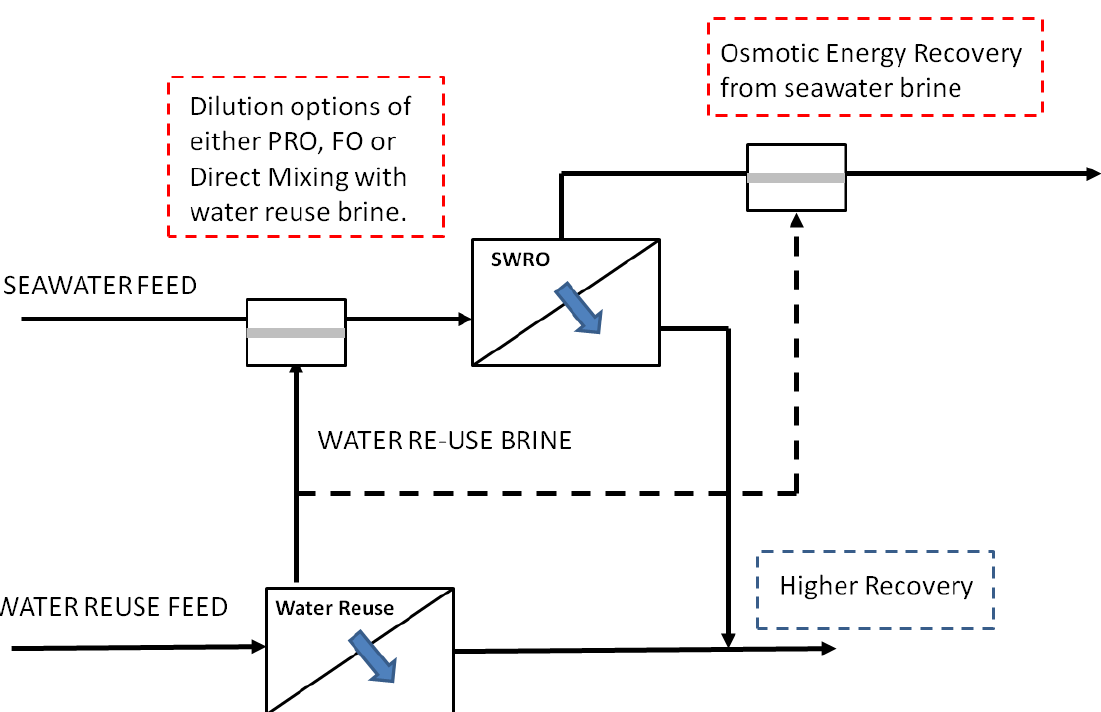
Figure 1. Proposed configuration of Hybrid Process. Adapted from Singapore-Netherlands Water Challenge 2011/2012